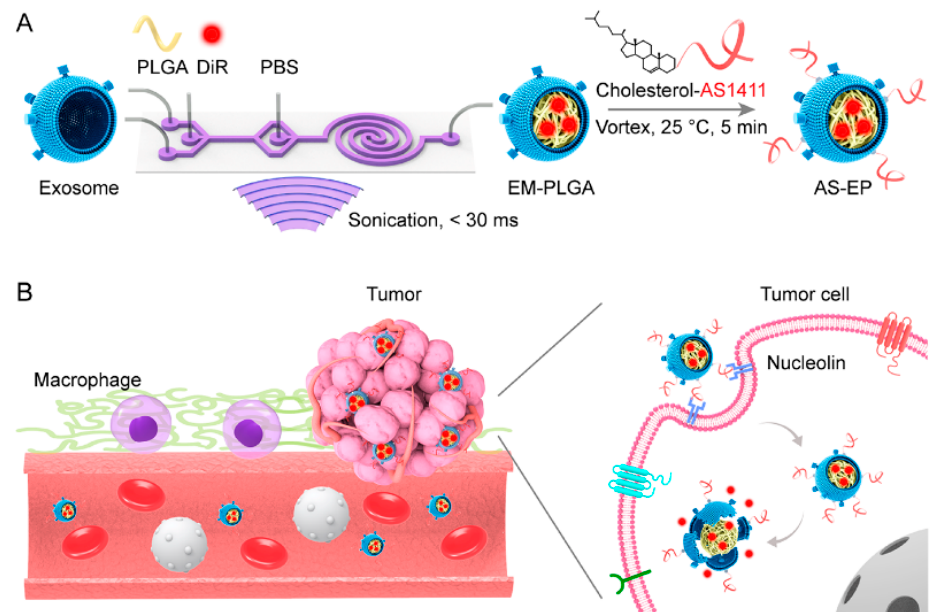
Figure 12. The scheme of PNPs composed of exosome shell (EM) and PLGA core and modified by AS1411 aptamers (AS-EP) for tumor targeting: ( A ) Scheme of preparation AS-EP; ( B ) scheme of AS-EP extended circulation in blood. The PNPs were characterized by reduced uptake by macrophages, and by enhanced targeting to tumor cells with overexpressed nucleolin. Reproduced from Han et al. [219] with permission of American Chemical Society.